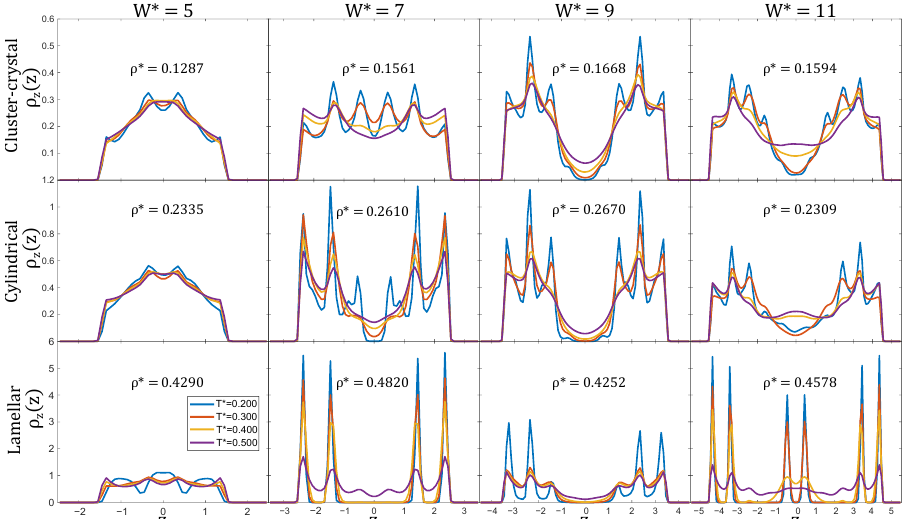
(left)) or formed by adding particles at the surface of an icosahedral cluster (e.g., the cluster with n = 24 shown in Figure 6).